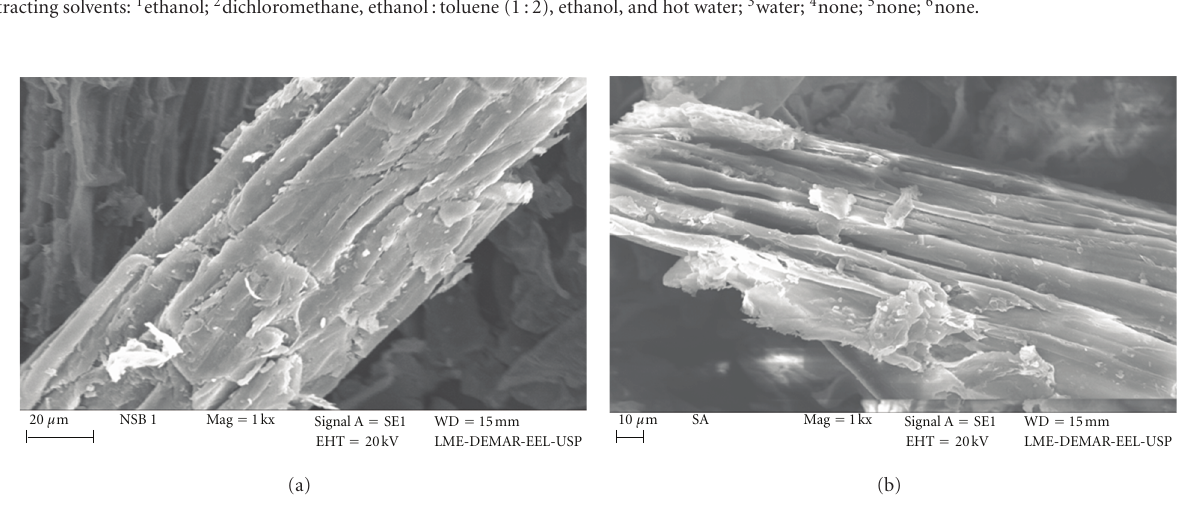
Figure 4: SEM of natural SB (a) and cellulignin obtained after dilute sulfuric acid pretreatment (b)